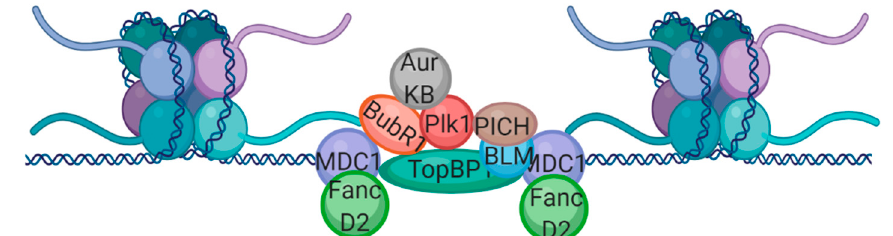
Figure 1. Acentric chromosomes resulting from DNA breaks or replication stress could lead to chromosomal instability if incorrectly segregated. We propose that multiprotein complexes made of DDR and SAC proteins form to tether broken chromosome fragments and facilitate accurate chromosome segregation. Image created using BioRender.